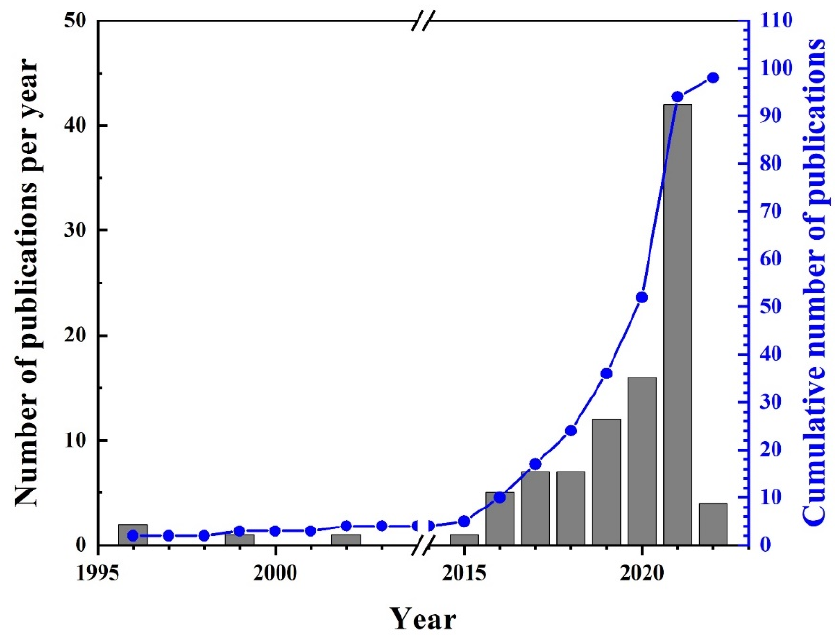
Figure 1. Number of publications relating to the metal MEX from 1996 to February 2022. Data from